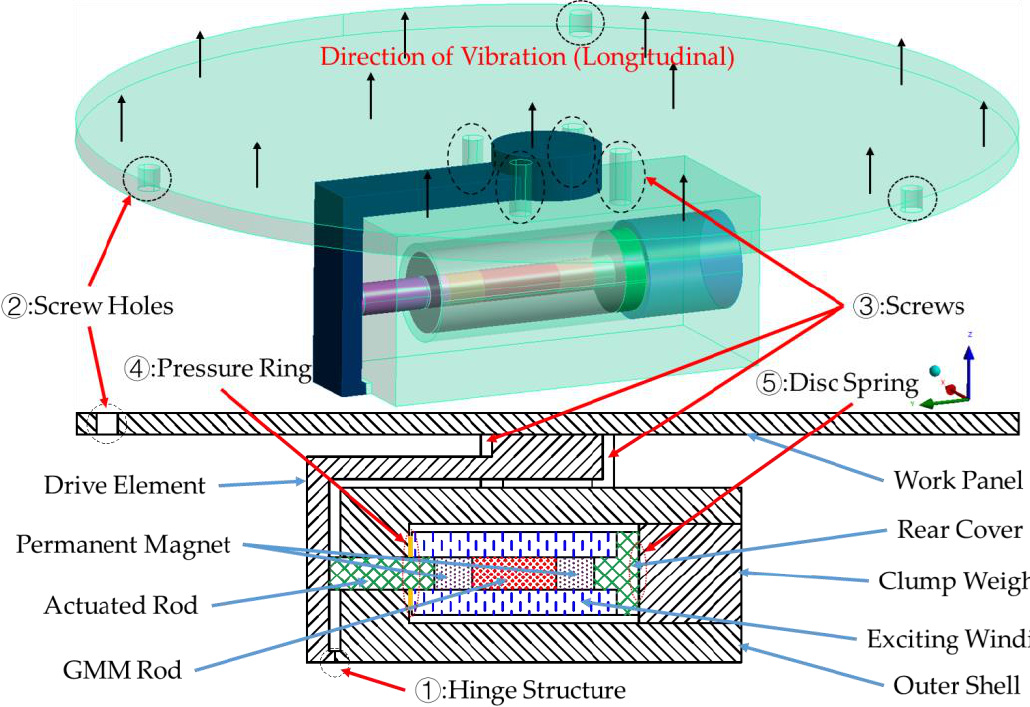
Figure 1. Original configuration diagram of the GMM transducer.